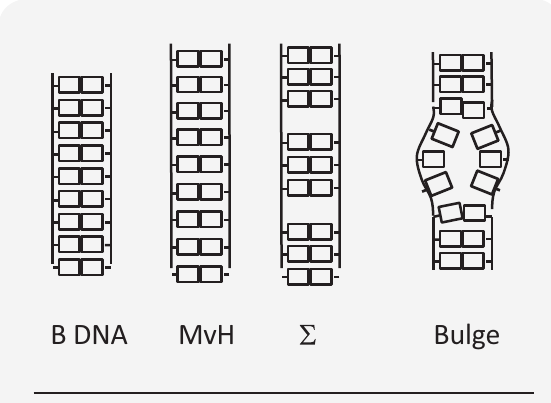
Figure 11. Various hypothetical DNA opening and elongation mechanism models. From left to right: B DNA structure, MvH (McConnel — von Hippel) homogeneous longitudinal elongation, Σ DNA inhomogeneous elongation, bulge base-pair opening. Sketch kindly made by Dr Bobo